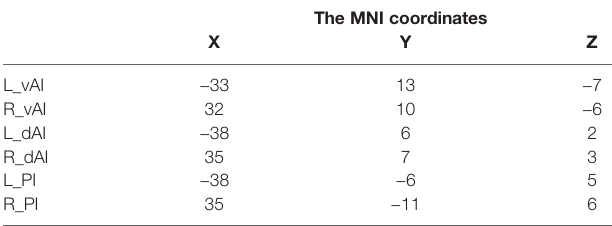
TABLE 1 | The MNI coordinates of the ROIs.